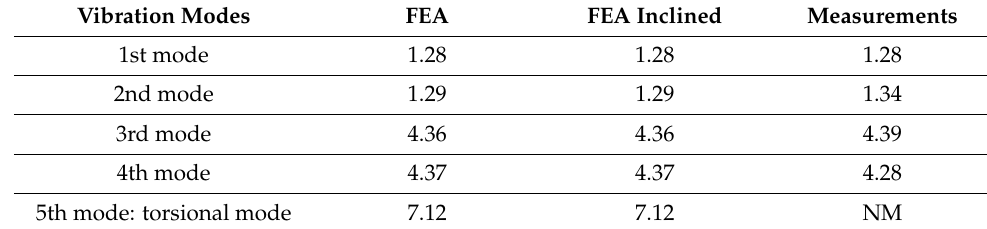
Figure 21. Estimation of the residual inclination and the model with residual inclination: ( a ) residual drift of the minaret in the vertical plane of overall inclination; ( b ) model with grid lines added. Table 6. Resonant frequencies of the numerical model compared to ambient vibration test results.